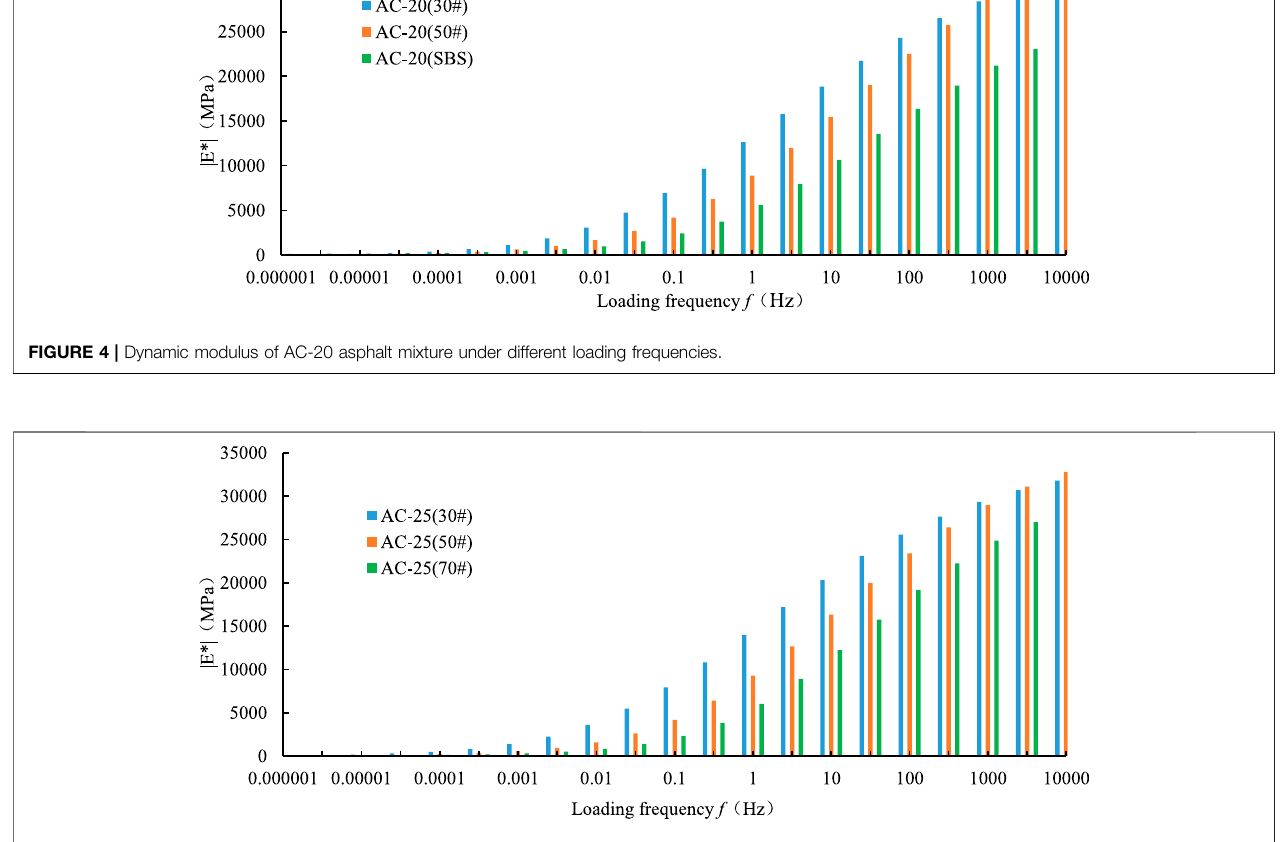
FIGURE 5 | Dynamic modulus of AC-25 asphalt mixture under different loading